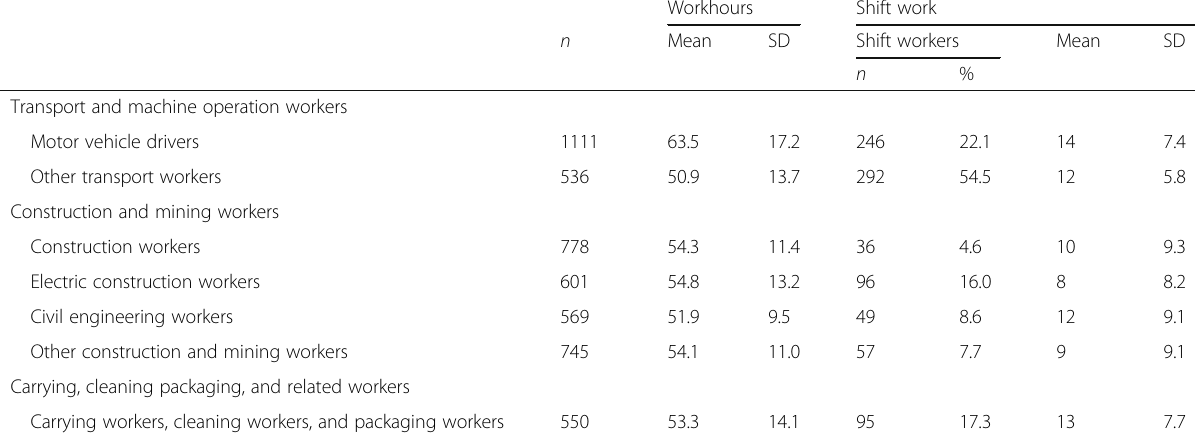
Table 2 Workhours and shift work according to occupations ( N = 39,315)